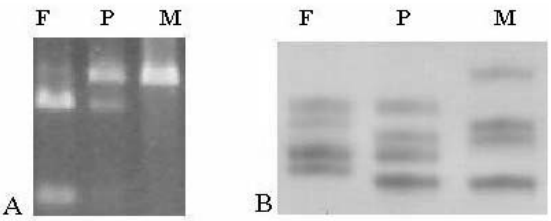
Figure 1 - Exclusion of uniparental disomy by comparison of patient and parental genotypes. Inheritance of maternal and paternal alleles as as - sessed by (A) H19/RsaI RFLP and (B) microsatellite D11S4177 loci (F = father, M = mother, P =